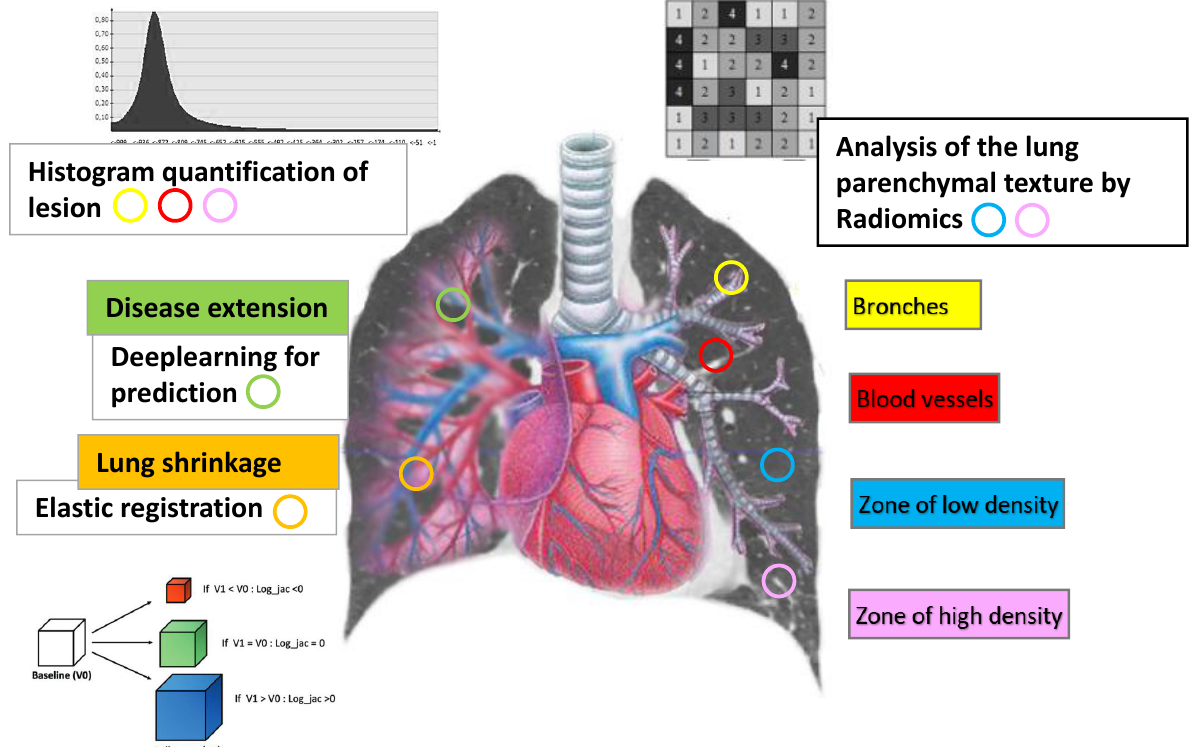
Figure 3. Lung anatomical and physiological parameters explored by artificial